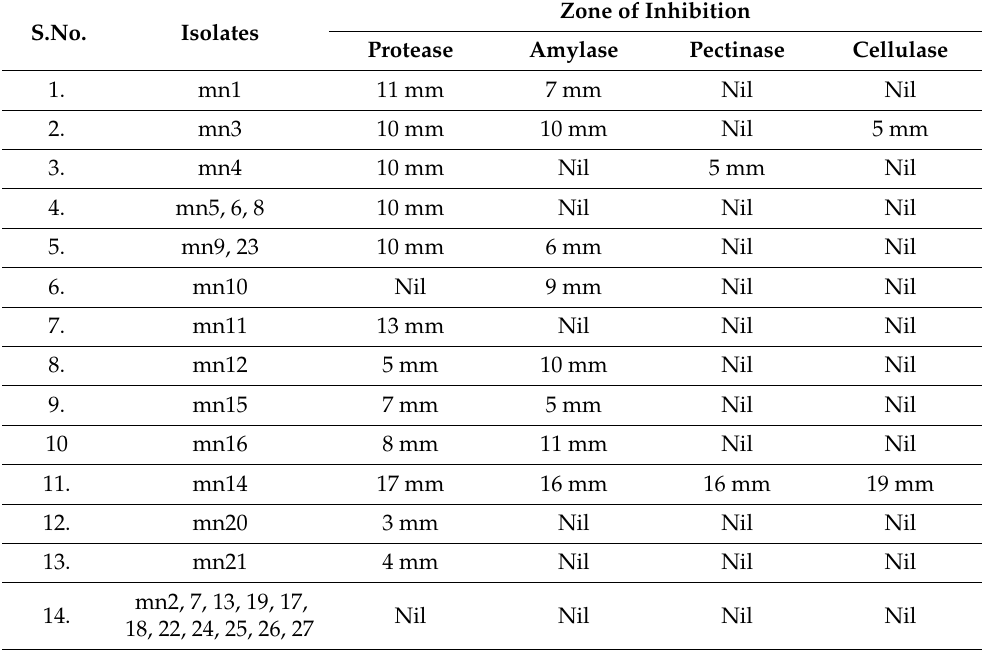
Table 2. Enzymatic characteristics of the